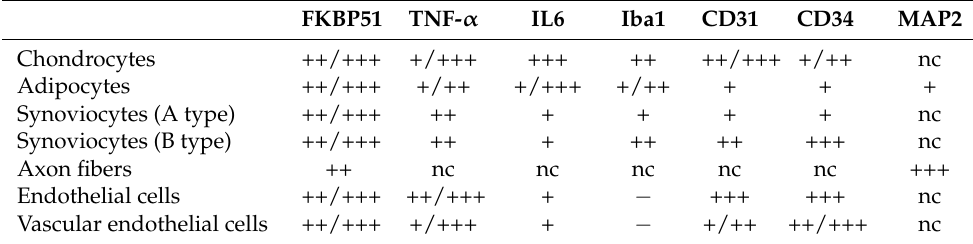
Table 2. Levels of specific fluorescence signal for FKBP51, TNF- α , IL-6, Iba1, CD31, CD34, and MAP2 in different cell types of tissues from patients with advanced knee OA (grade IV). Intensity levels: − no expression, + faint, ++ medium and +++ high. NC, not checked.